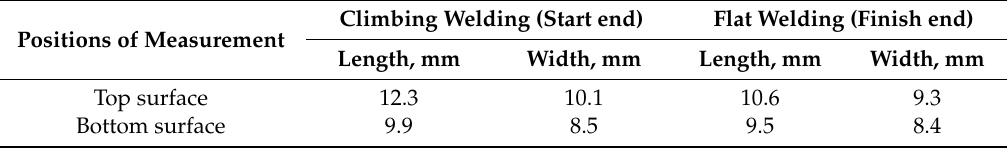
Table 4. Dimensions of weld pools numerically predicted for flat and climbing welding positions.